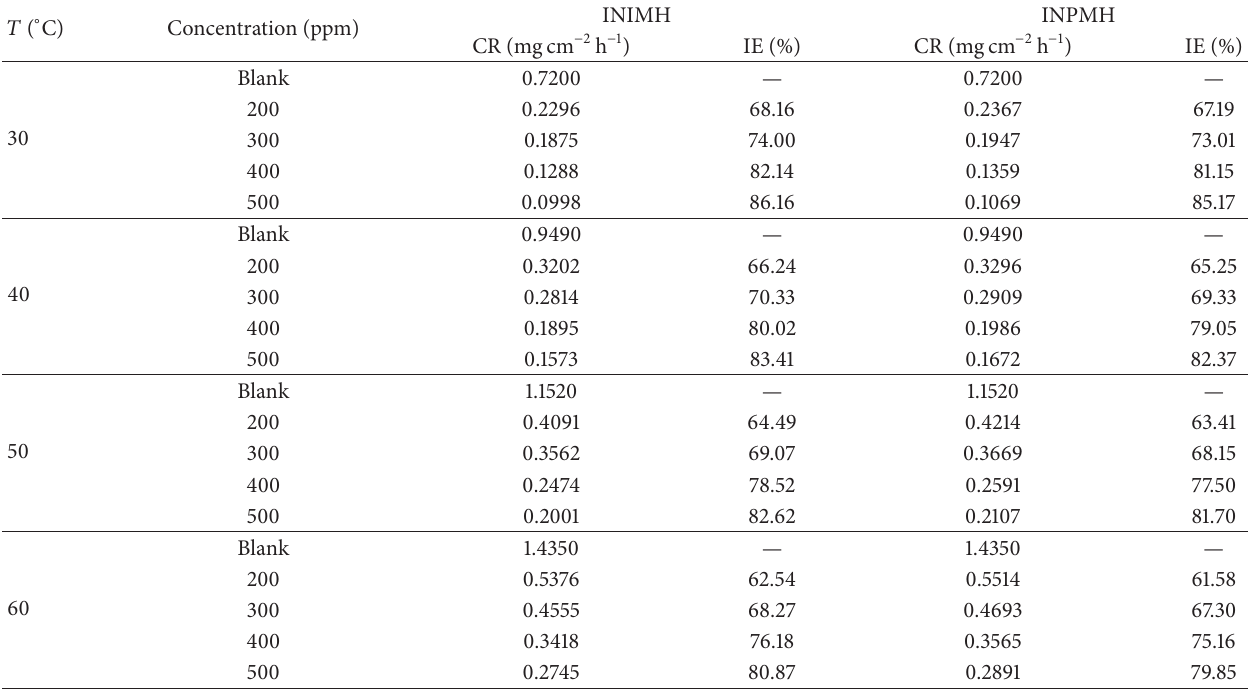
Table 1: CR and IE (%) obtained from mass loss measurements of MS in 0.5 M HCl solution containing various concentrations of INIMH and INPMH at different temperatures.